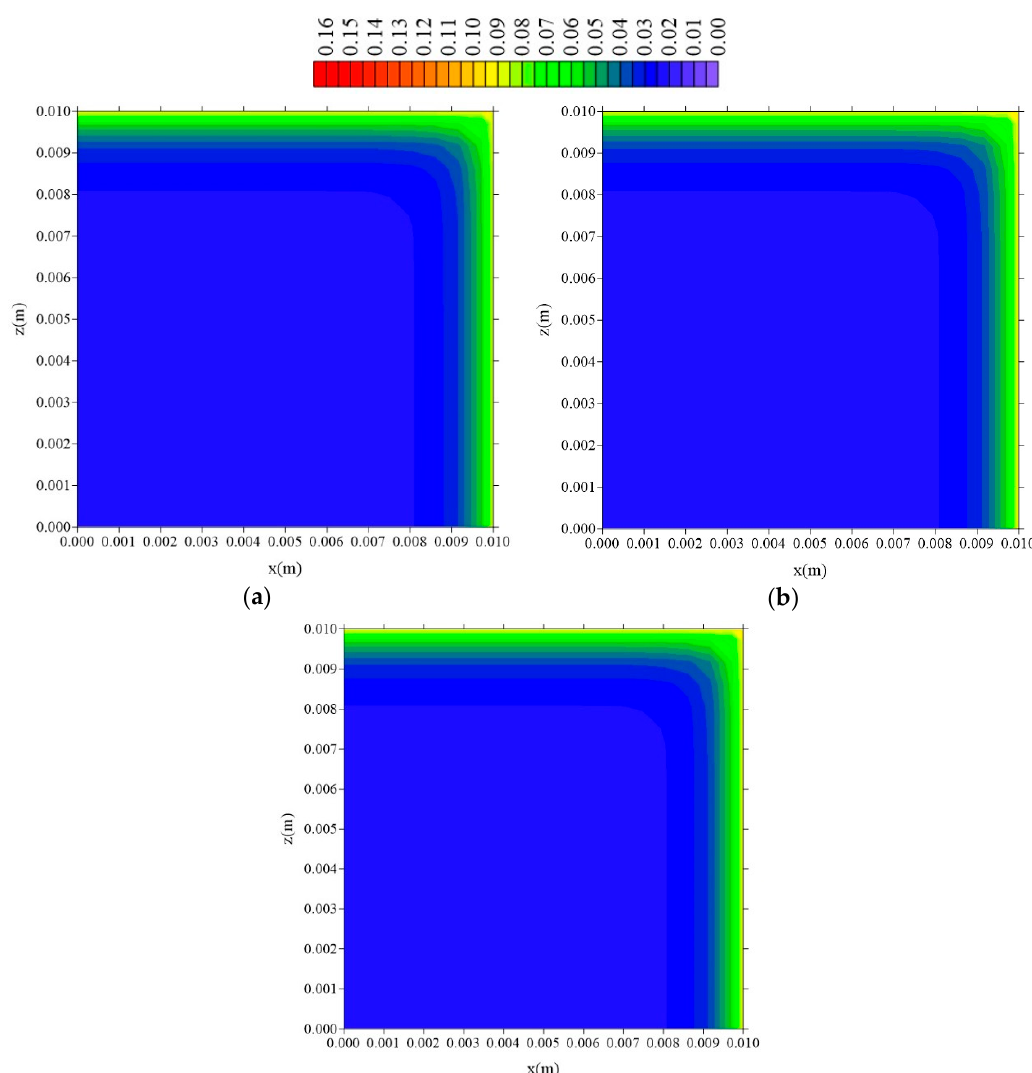
Figure 19. Distribution of the entrapped solute concentration (S in kg/kg) in the plan z = R z /2 and different distances l x (t = 211 h; Cases 8, 9, and 10). In which ( a ) l x = 0.01 m; l y = 0.01 m and l z = 0.1